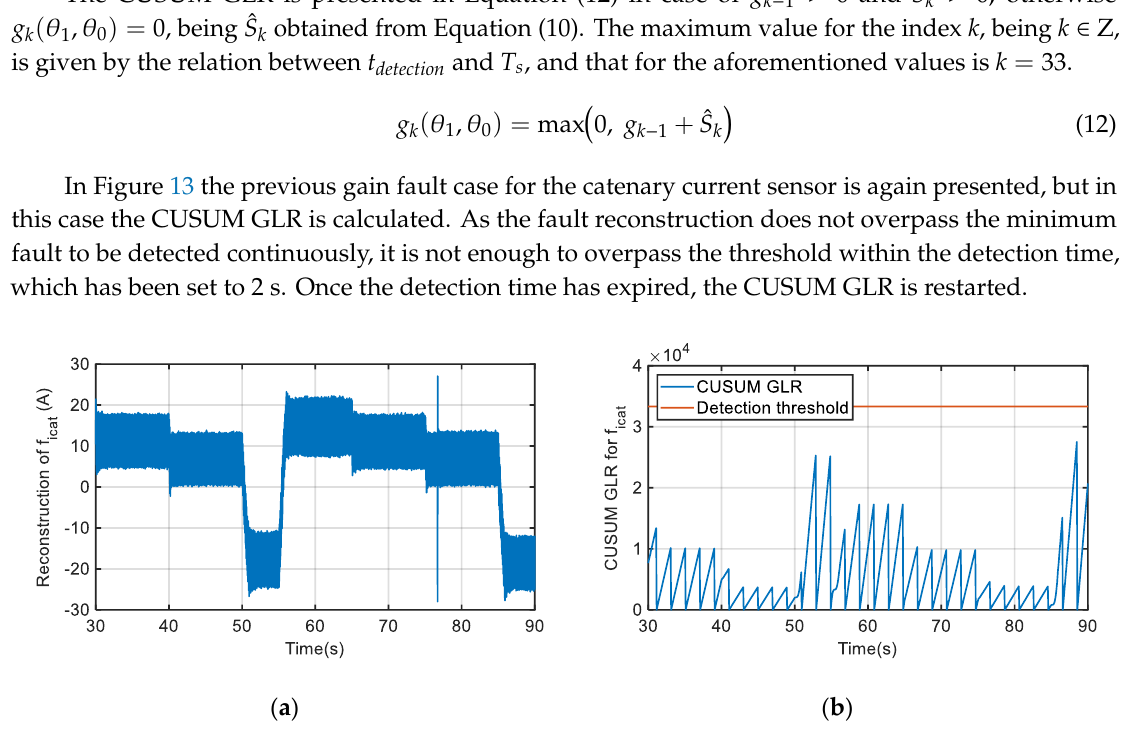
( b ) Figure 14. Gain fault injection in DC-link voltage sensor. ( a ) DC-link voltage sensor fault reconstruction. ( b ) CUSUM GLR calculation. Another case for the catenary current sensor is presented in Figure 15. An offset fault equal to +50 A is injected in the catenary current sensor measurement. As the fault injected is always over the minimum fault to be detected, set to 20 A, the CUSUM GLR calculation always overpasses the threshold within the detection time. The CUSUM GLR calculation is restarted every 2 s, as Figure 15c shows. In this case, the fault detection approximately takes 0.3 s, as it is shown in Figure 15d. As previously mentioned, the higher the fault, the shorter the time for fault detection. In the case that the injected offset fault is decreased to +20 A, which is a critical value around the minimum fault to detect, the time needed for detection should be close to the 2 s set for detection time, but it could be longer, depending on the fault reconstruction average value, which is slightly influenced by the operating point. Thus, for catenary current fault reconstruction data during 15 s and the offset fault permanently injected, only in some cases the CUSUM GLR calculation overpasses the threshold, and in consequence, the fault is detected within the detection time. Thus, this can suppose a time delay in the fault detection, as it is not detected in every time window, as it is shown in Figure 16. Once the threshold is overpassed, a logical fault indicator is activated, indicating the presence of a fault in the corresponding sensor. The key points of the fault evaluation are the robustness of the detection and the absence of false positives, so a delay in the detection is not critical.